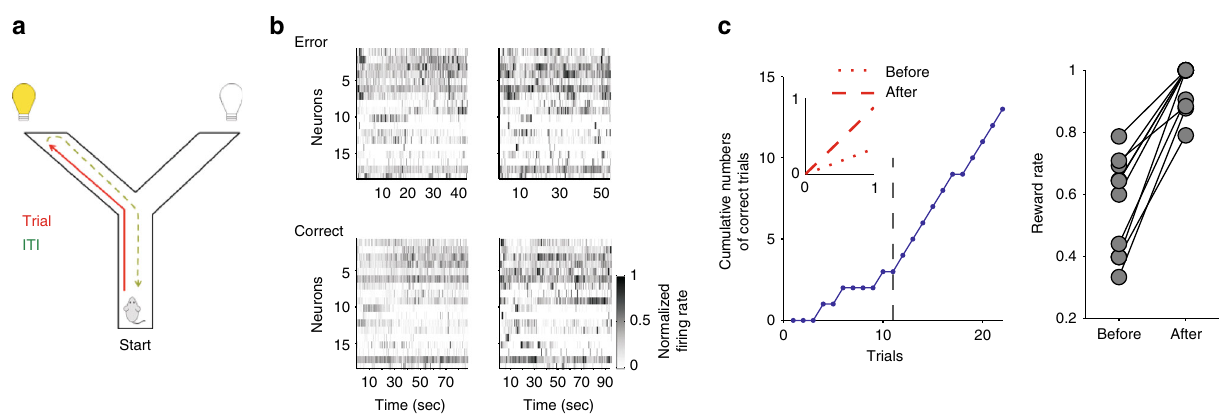
Fig. 1 Task and learning sessions. a Schematic representation of the Y-maze. The trial starts with the animal at the start of the departure arm, and ends when it reaches the end of the chosen arm. The inter-trial interval (ITI) is a self-paced return back to the start position. b Examples of medial prefrontal cortex population activity during inter-trial intervals from the same session (two following errors and two following correct choices of arm). The heatmaps show the spike trains for all recorded neurons, convolved with a Gaussian of width σ = 100 ms. c Learning sessions contain abrupt transitions in performance. Left panel: Learning curve for one example learning session. The cumulative number of correct trials shows a steep increase after the learning trial (black dashed line), indicating the rat had learnt the correct rule. Inset: fi tted linear regressions for the cumulative reward before (dotted) and after (dashed) the learning trial, quantifying the large increase in the rate of reward accumulation after the learning trial. Right panel: the rate of reward accumulation before and after the learning trial for every learning session (one pair of symbols per learning session; one session ’ s pair of symbols are obscured). The rate is given by the slopes of the fi tted regression